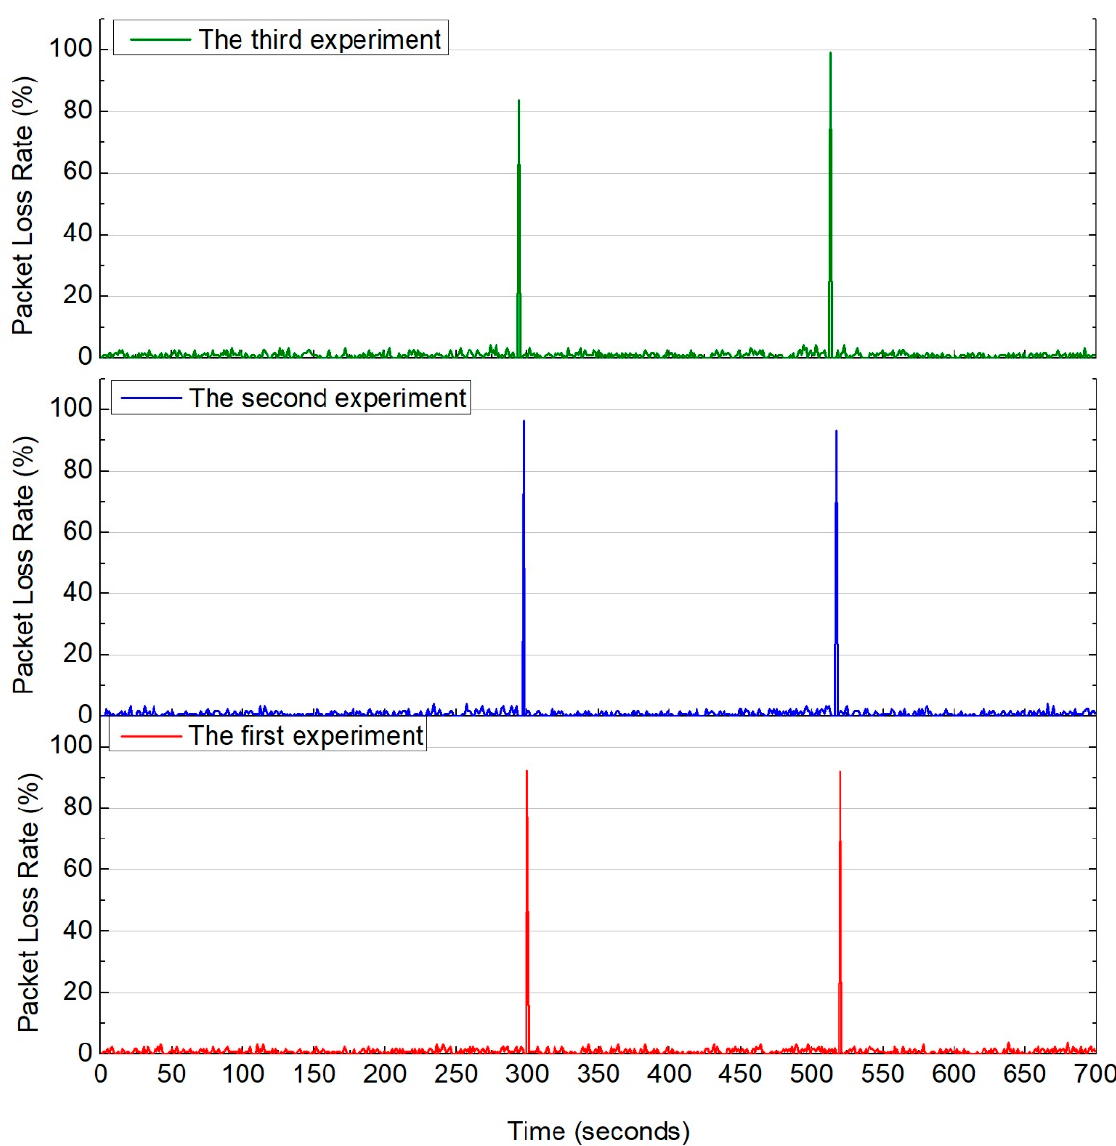
Figure 22. The packet loss rates of three experimental results of the LTE event A3 handover mecha- nism.